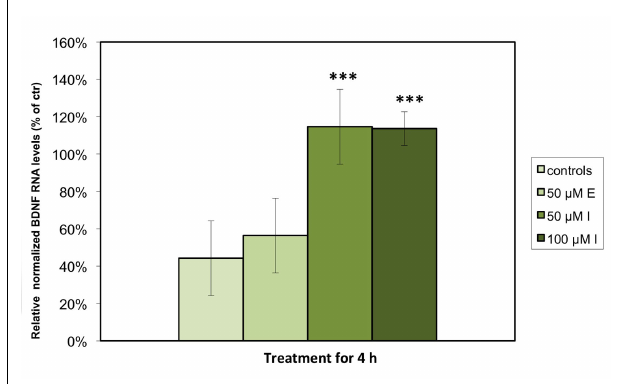
FIGURE 1 | Imipramine but not escitalopram increases the expression of Bdnf RNA in rat astrocyte cell cultures. The cells were incubated for 4h with either 50 μ M escitalopram (E), 50 μ M imipramine (I), or 100 μ M imipramine (I). RNA levels of Bdnf were analyzed by quantitative real time PCR. Results are expressed as relative levels after normalization against housekeeping genes ( Gapdh , Arp , and 18S ) in percentages of control cells and represent the means of six independent experiments ± SD. Data were statistically analyzed using non-parametric Kruskal–Wallis-Test. *** p <